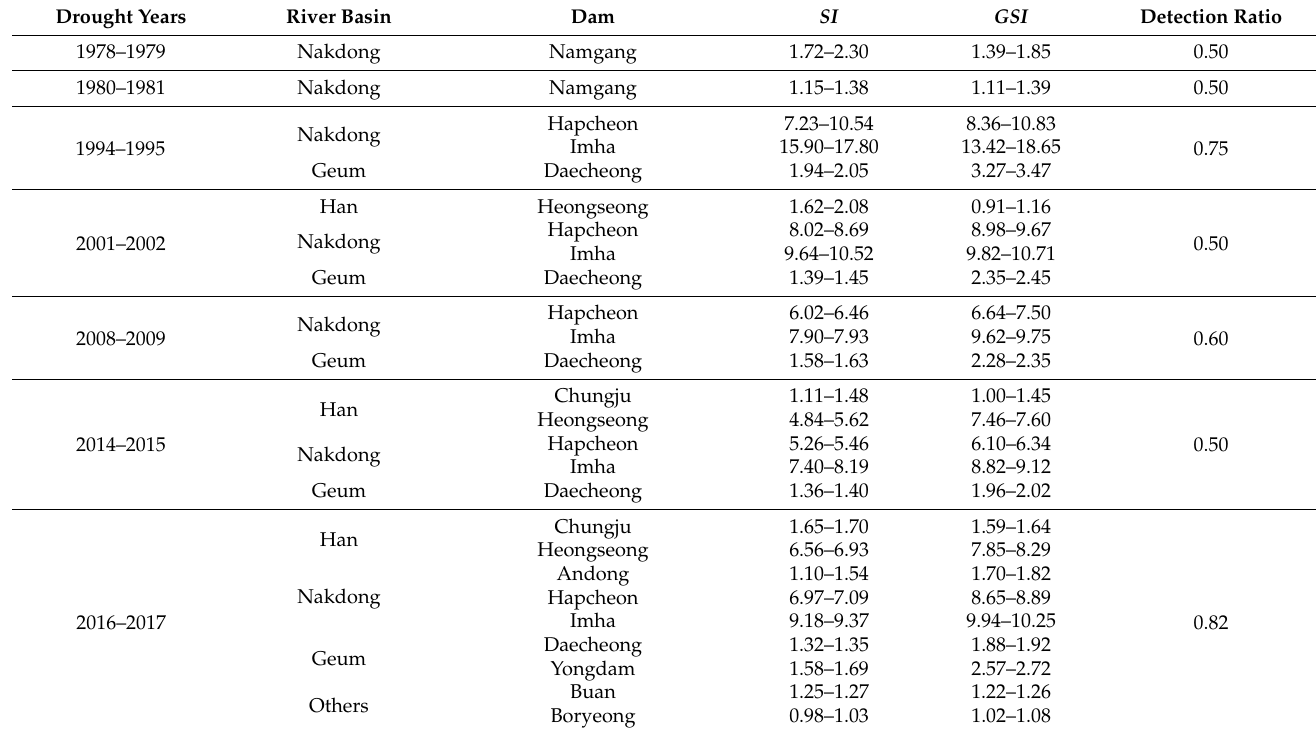
Table 2. The representative drought events and application results of SI and GSI for multipurpose dams in Korea. Drought